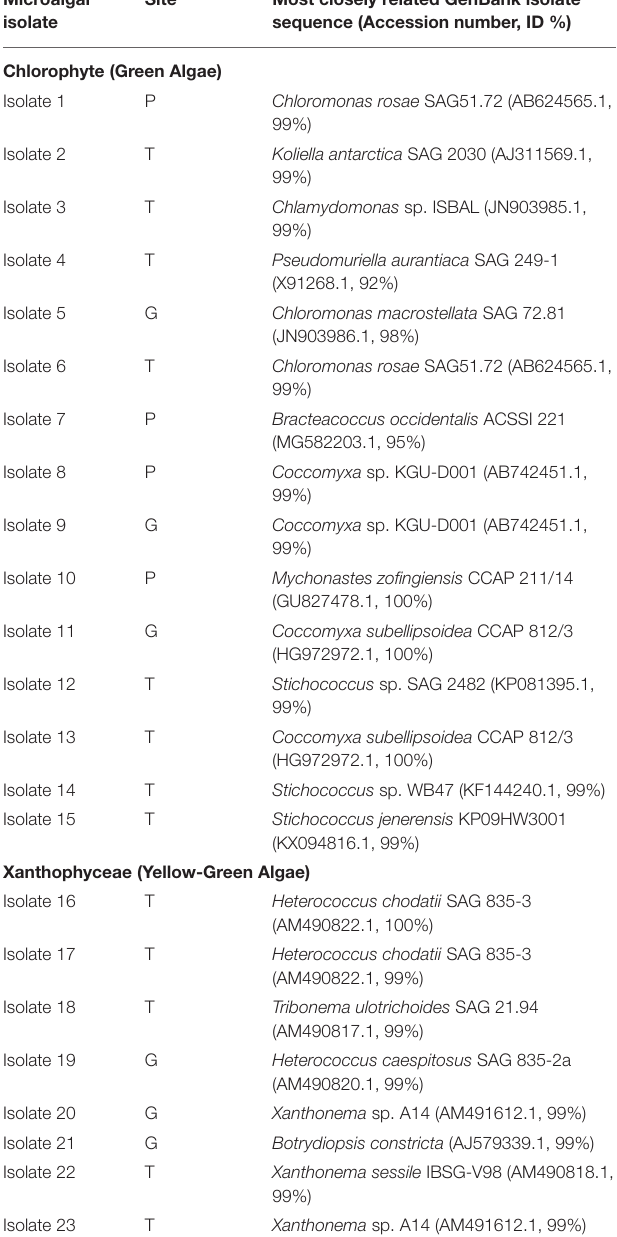
TABLE 5 | Pearson correlation coefficient between the biovolume of microbial phototrophs and soil physicochemical